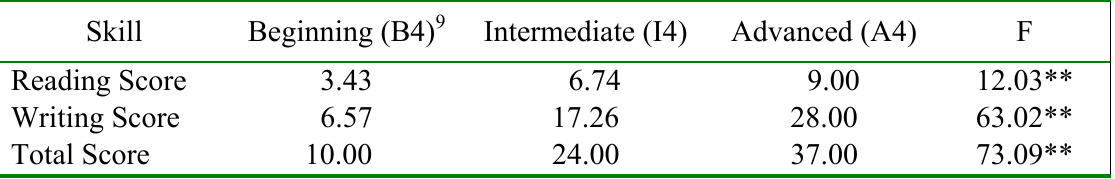
Analysis of Variance in Test